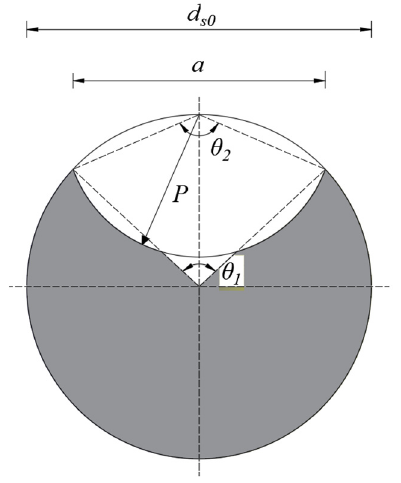
Figure 7. Schematic diagram of pitting corrosion area.